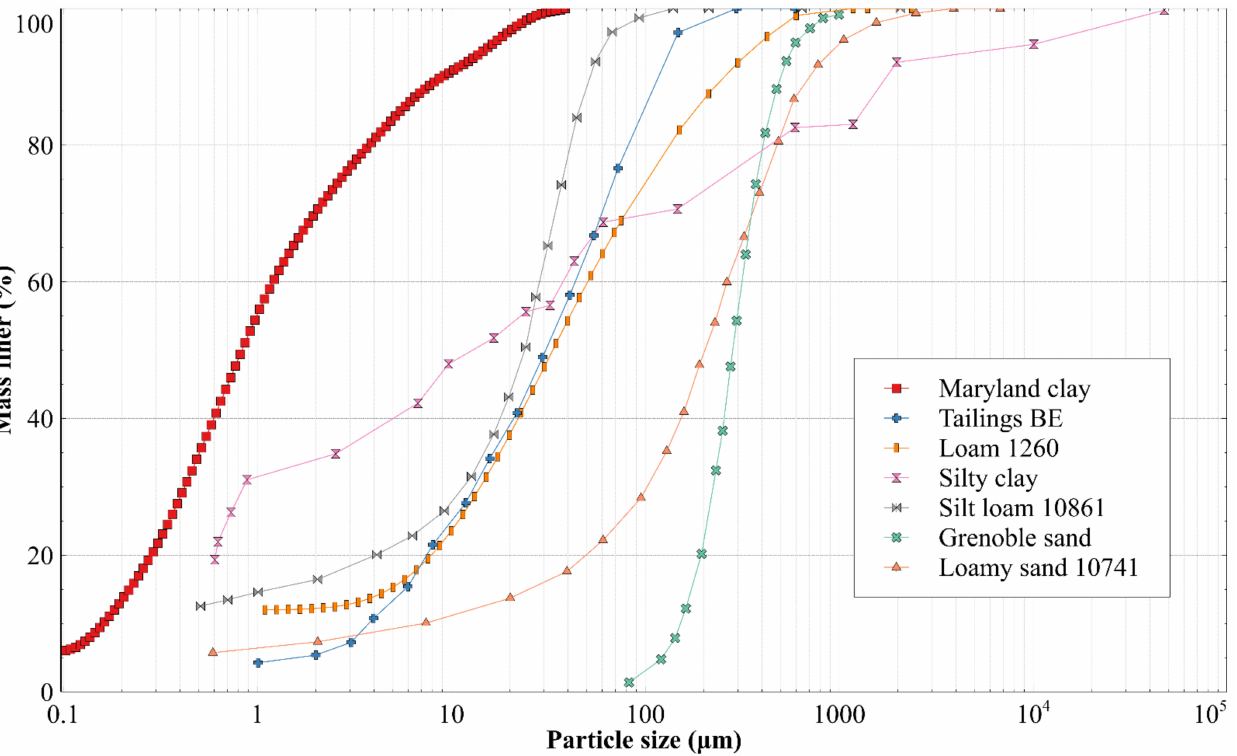
Figure A1. Grain size distributions of the materials sourced from the literature in Table 1; refer to Table 1 to find the data source of a material.